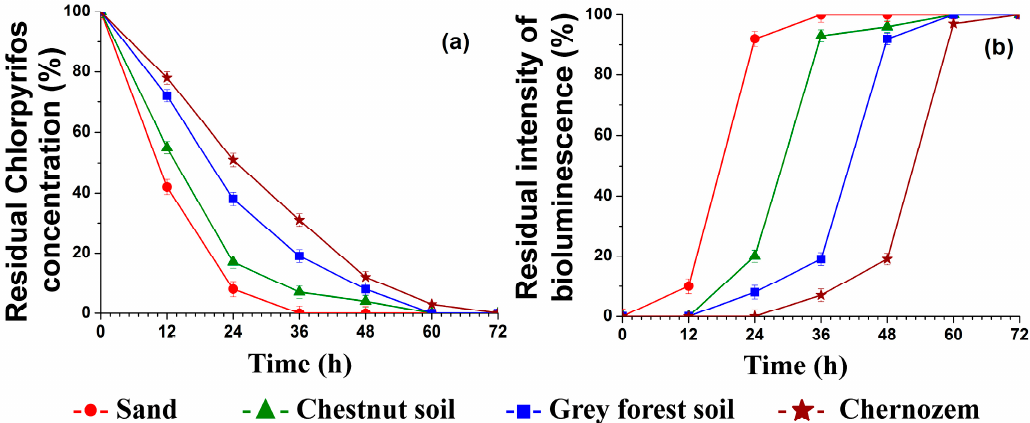
Figure 1. Destruction of 100 mg · kg − 1 soil of chlorpyrifos under the action of His 6 -OPH/PLE 50 immobilized in the plasma-modified (for 1.5 min) natural zeolite in various types of soil ( a ) and residual bioluminescence of immobilized Photobacterium phosphoreum used for evaluating the residual toxicity of the treated soil samples ( b ).